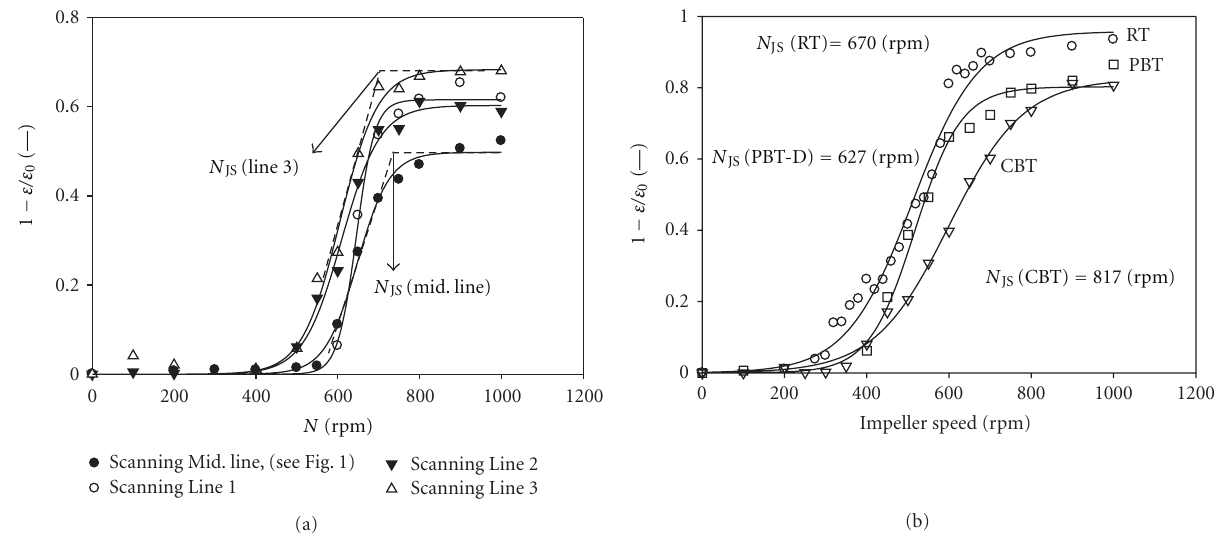
Figure 4: (a) Solid hold-up variation at the bottom of the vessel by increasing impeller speed, for 4 di ff erent scanning lines, impeller: RT, X : 30%, dp : 277 μ m, C/T : 0.33. (b) Comparison of just-suspended speed for di ff erent impellers. X : 10% wt/wt, C/T : 0.33.